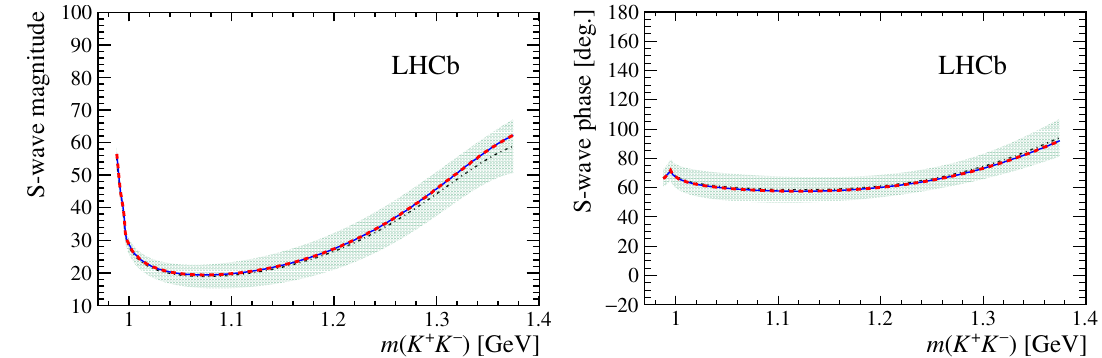
Figure 8 . (left) Magnitude and (right) phase of the total S-wave from the result of the Dalitz plot (cid:12)t with the isobar model. The black line corresponds to model A and the green band represents the statistical and systematic uncertainties added in quadrature. For comparison, the results of models B and C are shown as the blue solid and dashed thick red lines. Uncertainties on the S-wave magnitude and phase for models B and C are similar to those from model A and are not